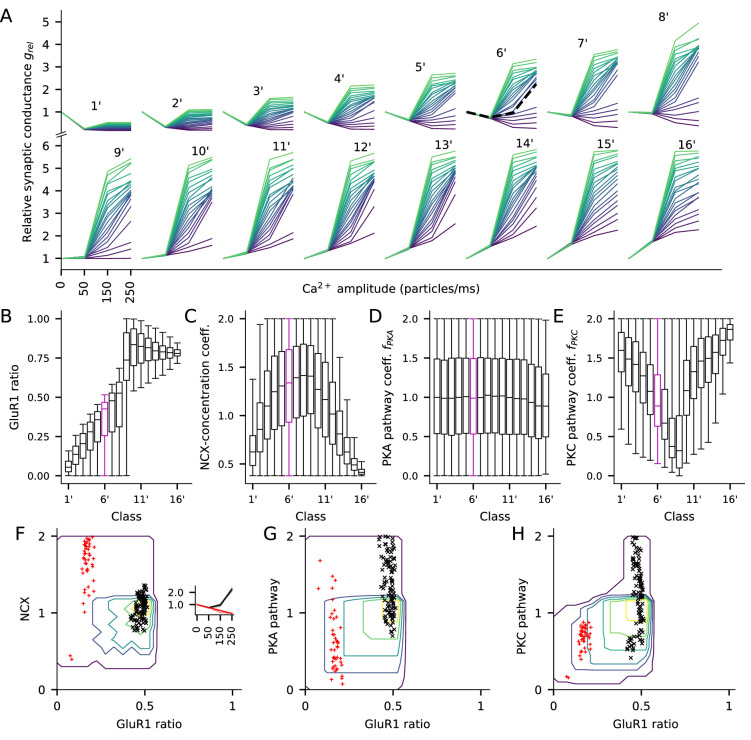
The PKC-pathway parameter distributions differ between clusters separated by their response to low (50 particles/ms) Ca2+ input.Here, the experiment of Figure 7 is repeated by clustering the parameters sets based on the relative synaptic conductance after a steady-state Ca2+ flux of 50 particles/ms (250 particles/ms in Figure 7) to highlight the contribution of the PKC-pathway parameter. (A) The LTP/LTD curves for all 16 classes (classes 1’—16’). Four values of Ca2+ input amplitude were considered: 0, 50, 150, and 250 particles/ms (x-axis; repeated and overlaid for space). The y-axis shows the relative synaptic conductance, that is, total synaptic conductance 15 min after the onset of the Ca2+ input divided by the total synaptic conductance before the Ca2+ input. 20 representative parameter sets are displayed from each class, coloured from purple (lowest relative synaptic conductance response for medium Ca2+ input) to green (highest conductance). The black, dashed trace in class 6’ (note that this is a different group than class six in Figure 7) represents the model with the default concentration parameters. (B–E) Distribution of model parameters, that is, GluR1 ratio (B), NCX-concentration coefficient (C), PKA pathway-concentration coefficient fPKA (D), and PKC pathway-concentration coefficient fPKC in the 16 classes. Class 6’ (purple) highlighted for further analysis. (F–H) GluR1 ratio plotted against NCX-concentration coefficient (F), fPKA (G), and fPKC (H) in class 6’. The contours represent the distribution of parameters (N = 7275) that produced class-6’ plasticity. No parameters yielding class-6’ plasticity were found beyond the purple contour, and the inner contours cover the parameter space where the distribution is higher than 0%, 20%, 40%, 60% or 80% of the maximal density value. The black and red markers represent parameter sets that produced two plasticity subclasses, namely, one where the total deviance (summed absolute difference) from the BCM-type plasticity produced by the default parameter set (black, N = 98) or from a linearly decreasing LTP (red, N = 44) was less than 0.2 (a.u.). Inset: The LTP/LTD plasticity curves of the two subclasses. The thick lines represent the centre of the subclasses (black: relative conductances in response to 50, 150, and 250 Ca2+ ions/ms: 0.76, 0.96, 2.24; red: relative conductances in response to 50, 150, and 250 Ca2+ ions/ms: 0.76, 0.52, 0.27).